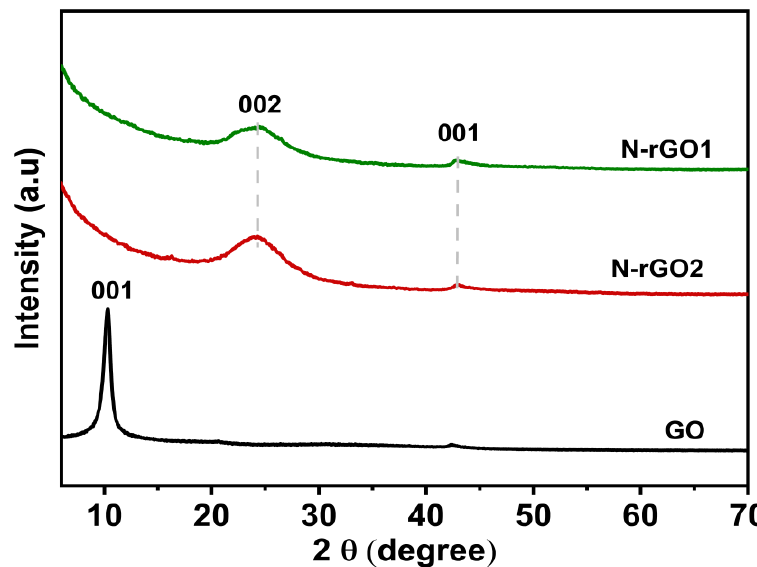
Figure 4. The graphical demonstration of the XRD plot of GO and N-rGOs. After the solvothermal treatment, small and broad peaks centered at 2 Ɵ = 24.3° and 2 Ɵ = 43.0° for N-rGOs were realized, corresponding to the 002 and 001 planes, respec- tively, instead of the sharp peak centered at 2 Ɵ = 10.5° for GO, indicating that the GO had been exfoliated and restacked during the doping process due to van der Waals and elec- trostatic forces. A shift in the peaks results in a bigger angle; as a result, the hexagonal structure ’ s unit cell volume decreases. In addition to the observed peak shift, the peaks become wider and vanish as the reduction temperature